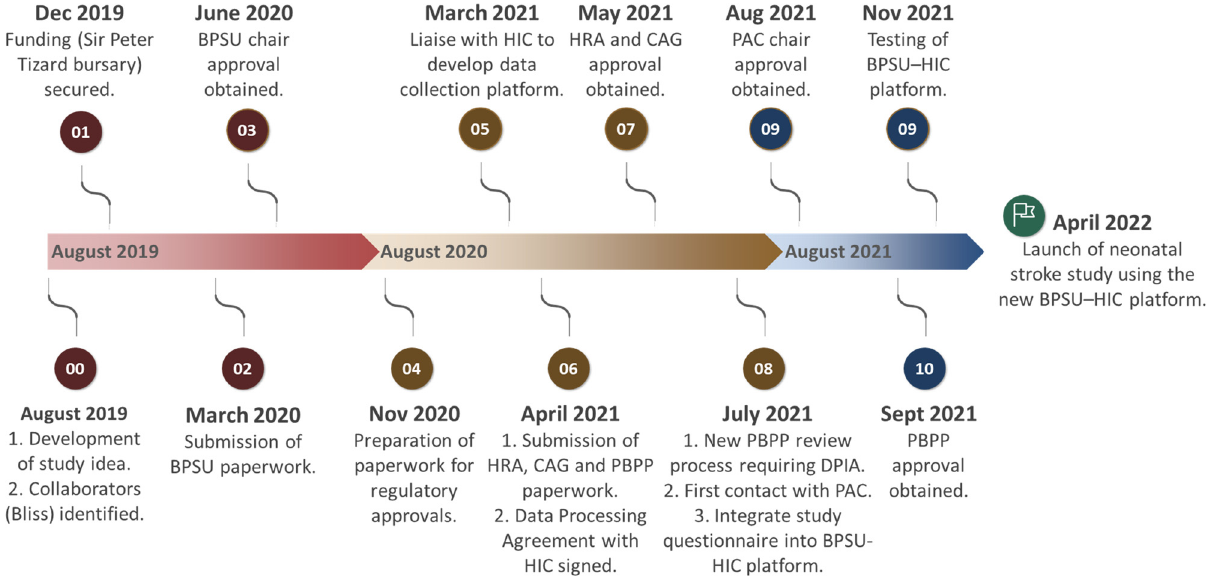
Figure 1: Timeline depicting the launch of the neonatal stroke surveillance study from the conceptualisation of the research idea. Study progress was halted for a year in March 2020 due to the COVID - 19 pandemic. BPSU = British Paediatric Surveillance Unit. HIC = Health Informatics Centre. HRA = Health Research Authority. CAG = Con fi dentiality Advisory Group. PBPP = Public Bene fi t and Privacy Panel. DPIA = Data Protection Impact Assessment. PAC = Privacy Advisory Committee of Northern